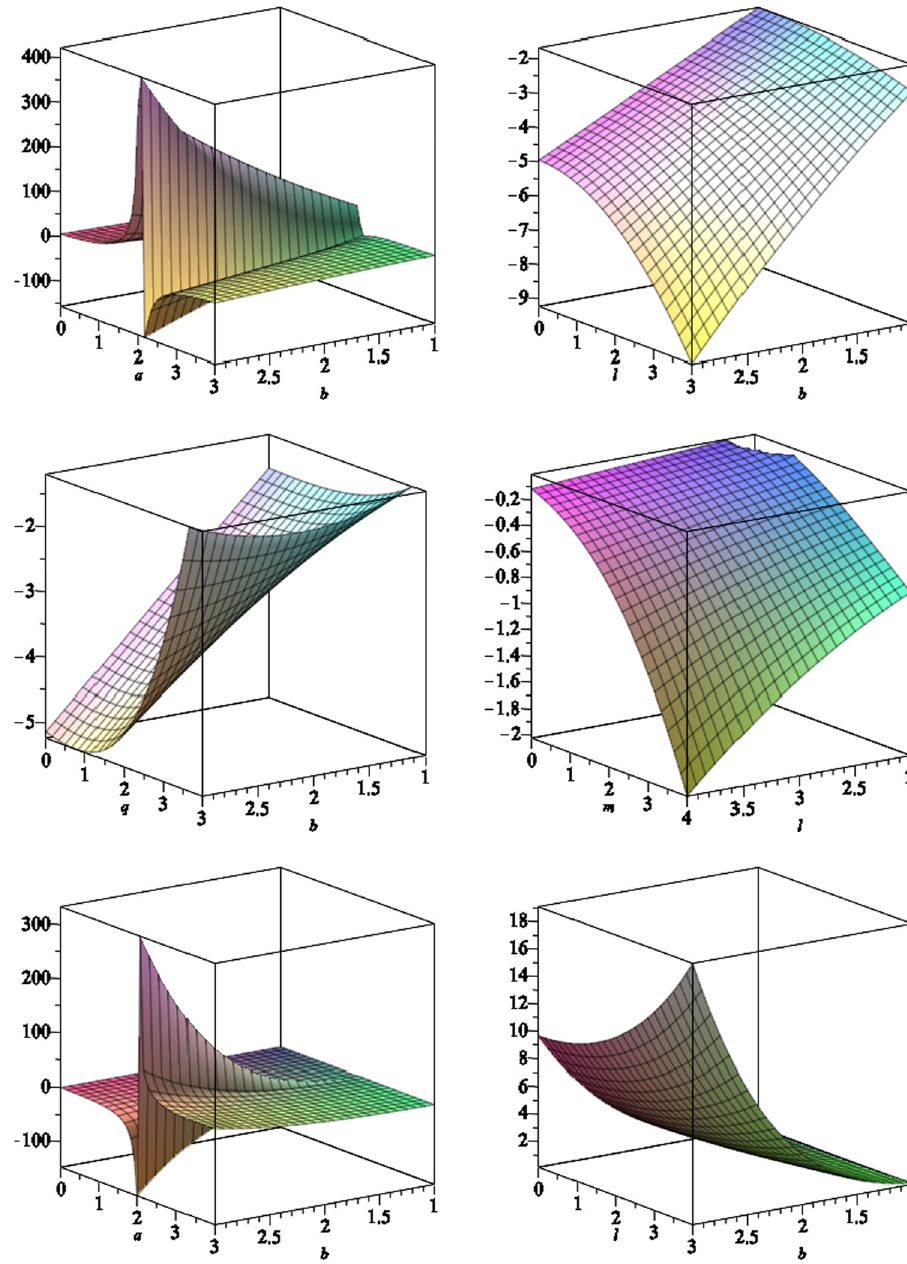
Fig. 14 The electric charge of the black hole as function of a , b (left) and l , b (right), where we set the other black hole parameters to a set of fixed